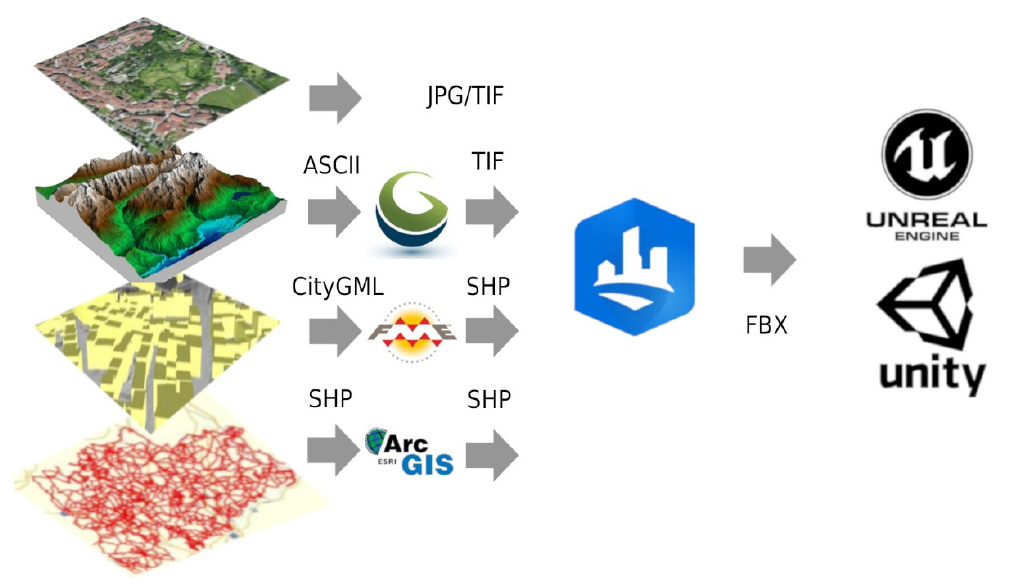
Figure 3. Proprietary production pipeline.